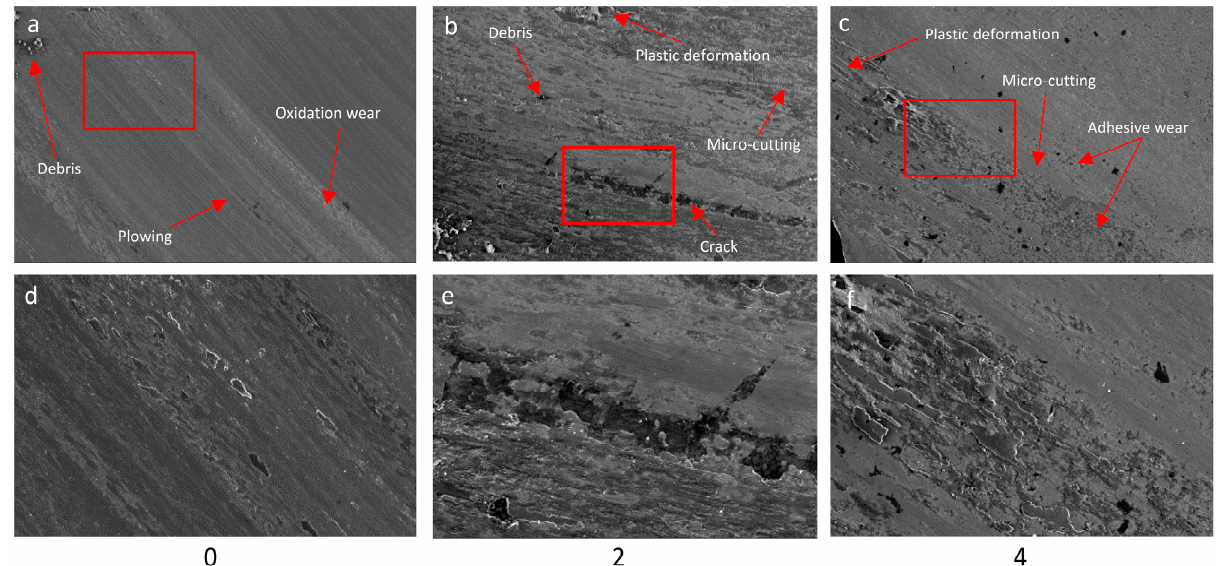
Figure 13. SEM image of worn surface pin after test: ( a , d ) 0; ( b , e ) 2; ( c , f ) 4.